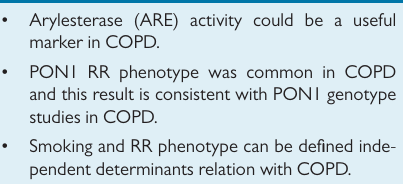
Figure 2. Travel of droplets using Wells evaporation–falling curve. [Reprinted with permission